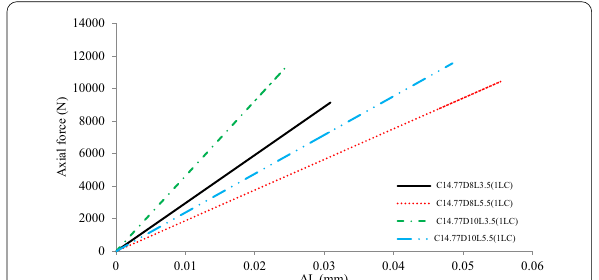
Fig. 12 Sliding force–deformation diagram in C14.77D8L3.5-1LC-2 and C14.77D8L5.5 -1LC-2, and C14.77D10L3.5-1LC-2 specimens.